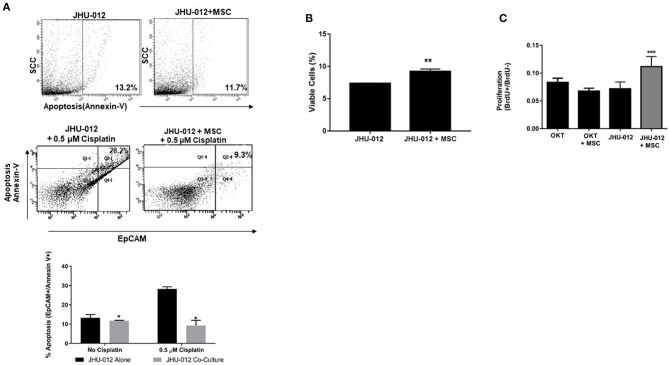
MSCs mediate decreased apoptosis with a concomitant increase cell viability and proliferation following 0.5 μM treatment with cisplatin in OSCC. JHU-012 cells grown alone or in 1:1 co-culture with MSCs were treated with 0.5 μM cisplatin and apoptosis, viability, and proliferation measured. (A) 1:1 co-culture of MSCs with JHU-012 resulted in a significant decrease in EpCAM+/annexin V+ cancer cells undergoing apoptosis compared to JHU-012 cells grown alone (*p < 0.0001, n = 3). (B) JHU-012/MSC co-cultures displayed enhanced viability compared to cancer cells alone (**p < 0.001, n = 3) and (C) cancer cell proliferation was significantly increased following cisplatin treatment in co-culture conditions compared to cancer cells grown alone and OKT negative controls grown alone or in co-culture with MSCs (***p < 0.026, n = 3).